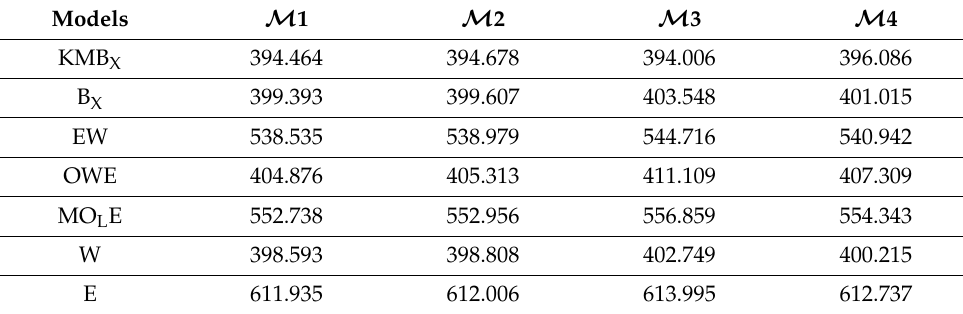
Table 12. Numerical values of M 1, M 2, M 3, and M 4 for the third data